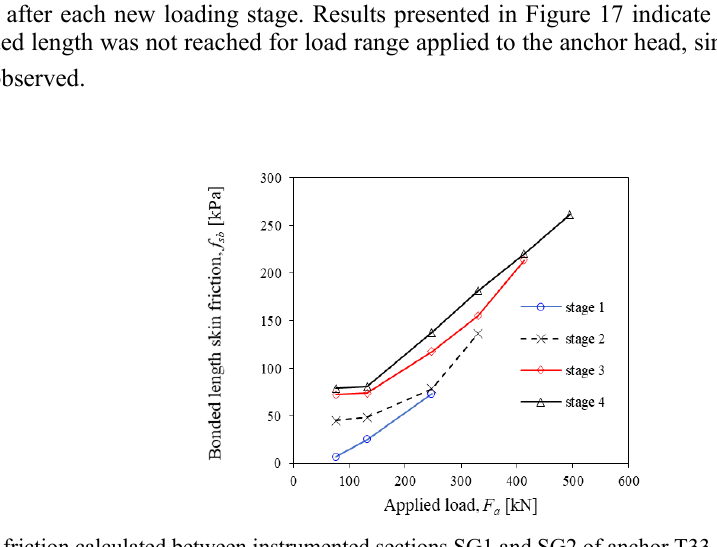
The skin friction on the bonded length ( )